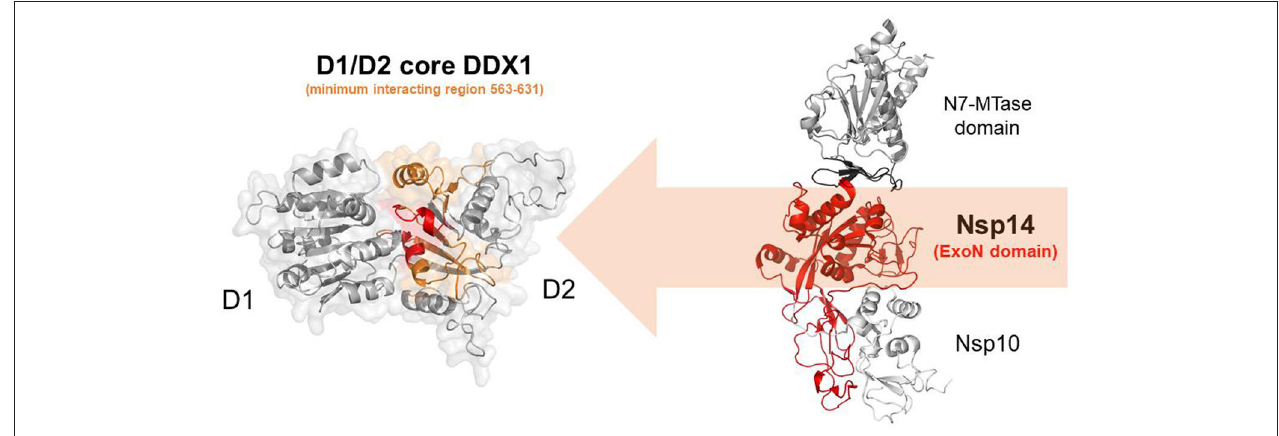
FIGURE 10 | Nsp14-mediated DDX1 hijacking by SARS-CoV-2. Cartoon representation of DDX1 D1D2 core (left)and Nsp14/Nsp10 (right) obtained by homology modeling. Nsp14 and DDX1 interaction involves the C-terminal region of DDX1 (orange) with motifs IV and V (red), and the ExoN domain of Nsp14